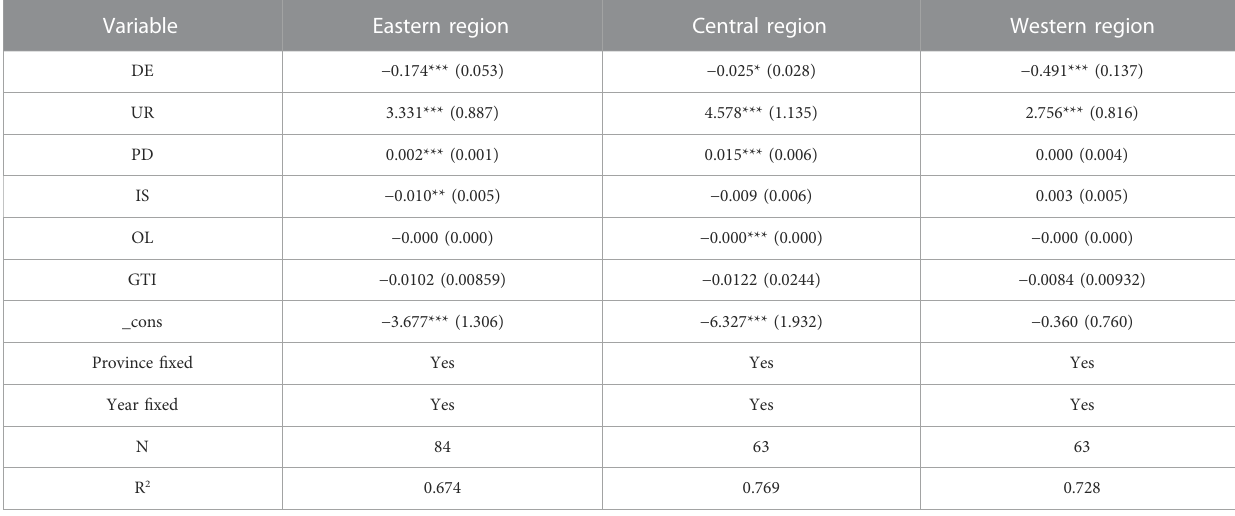
TABLE 4 Heterogeneous regression